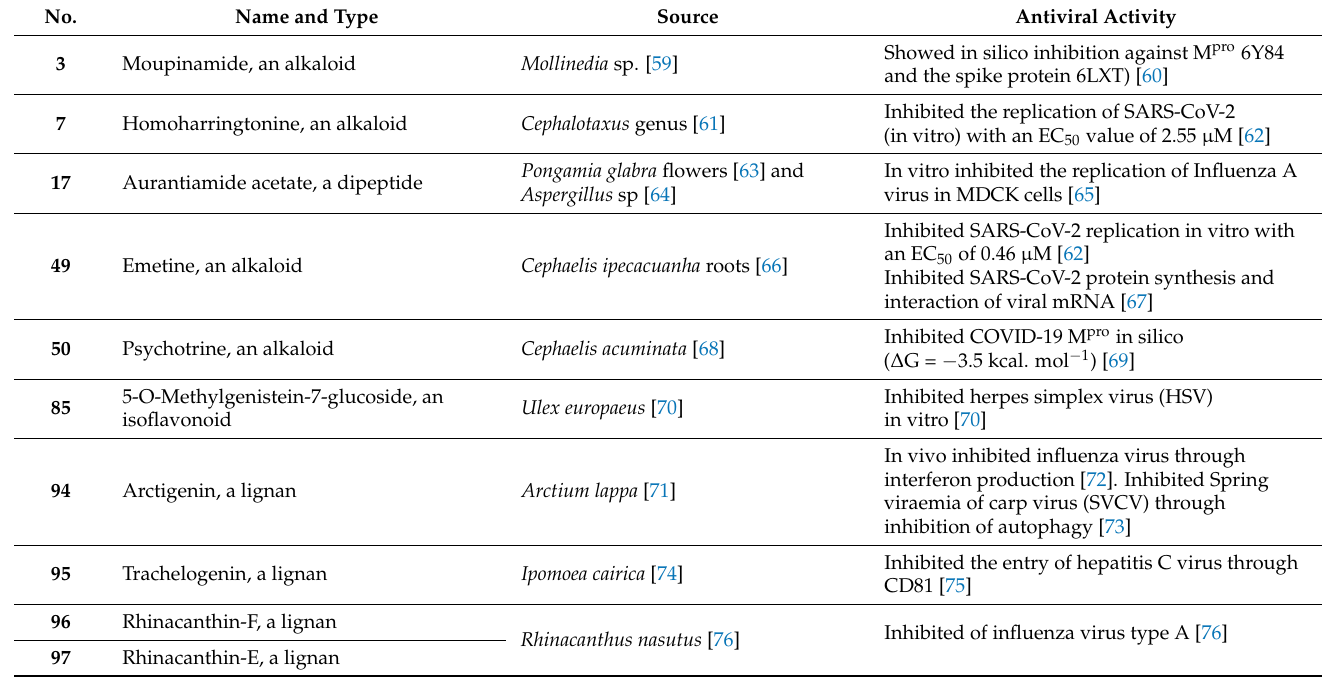
Table 2. Natural sources and antiviral activities of the most similar antiviral